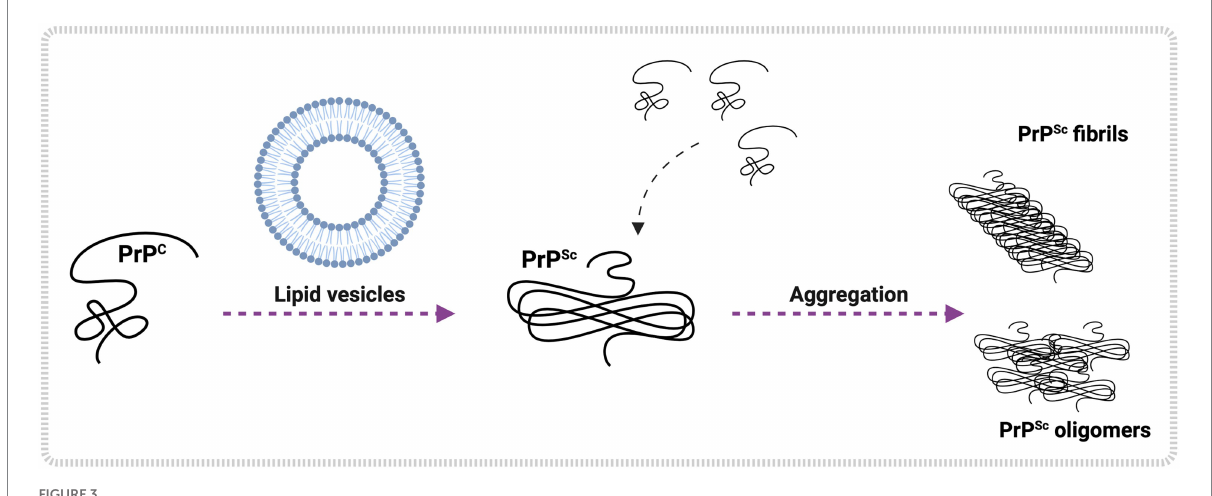
FIGURE 3 Lipid-mediated PrP C conversion and aggregation in vitro . In vitro studies show lipid vesicle interaction with PrP C , leading to PrP Sc formation. Examples of glycerophospholipids are POPG, PE, PA, and others. Once formed, PrP Sc converts more PrP C to the pathological form, initiating an aggregation process that may culminate in the shape of PrP Sc oligomers and PrP Sc fibrils. Created with